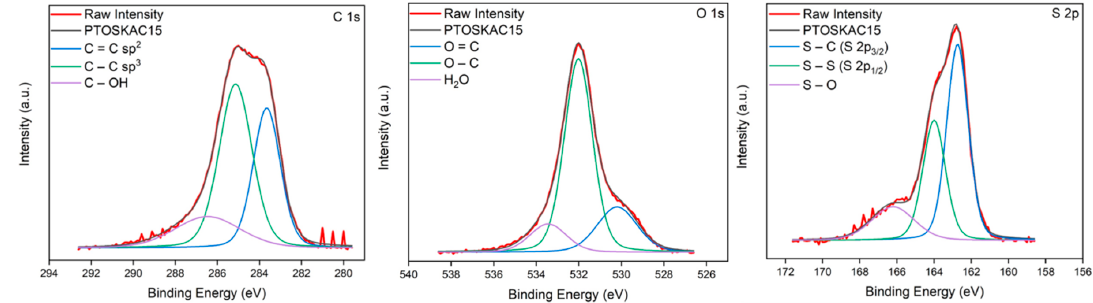
Table 4. Subdivision of carbon, oxygen and sulfur signals for PTOSKAC15.